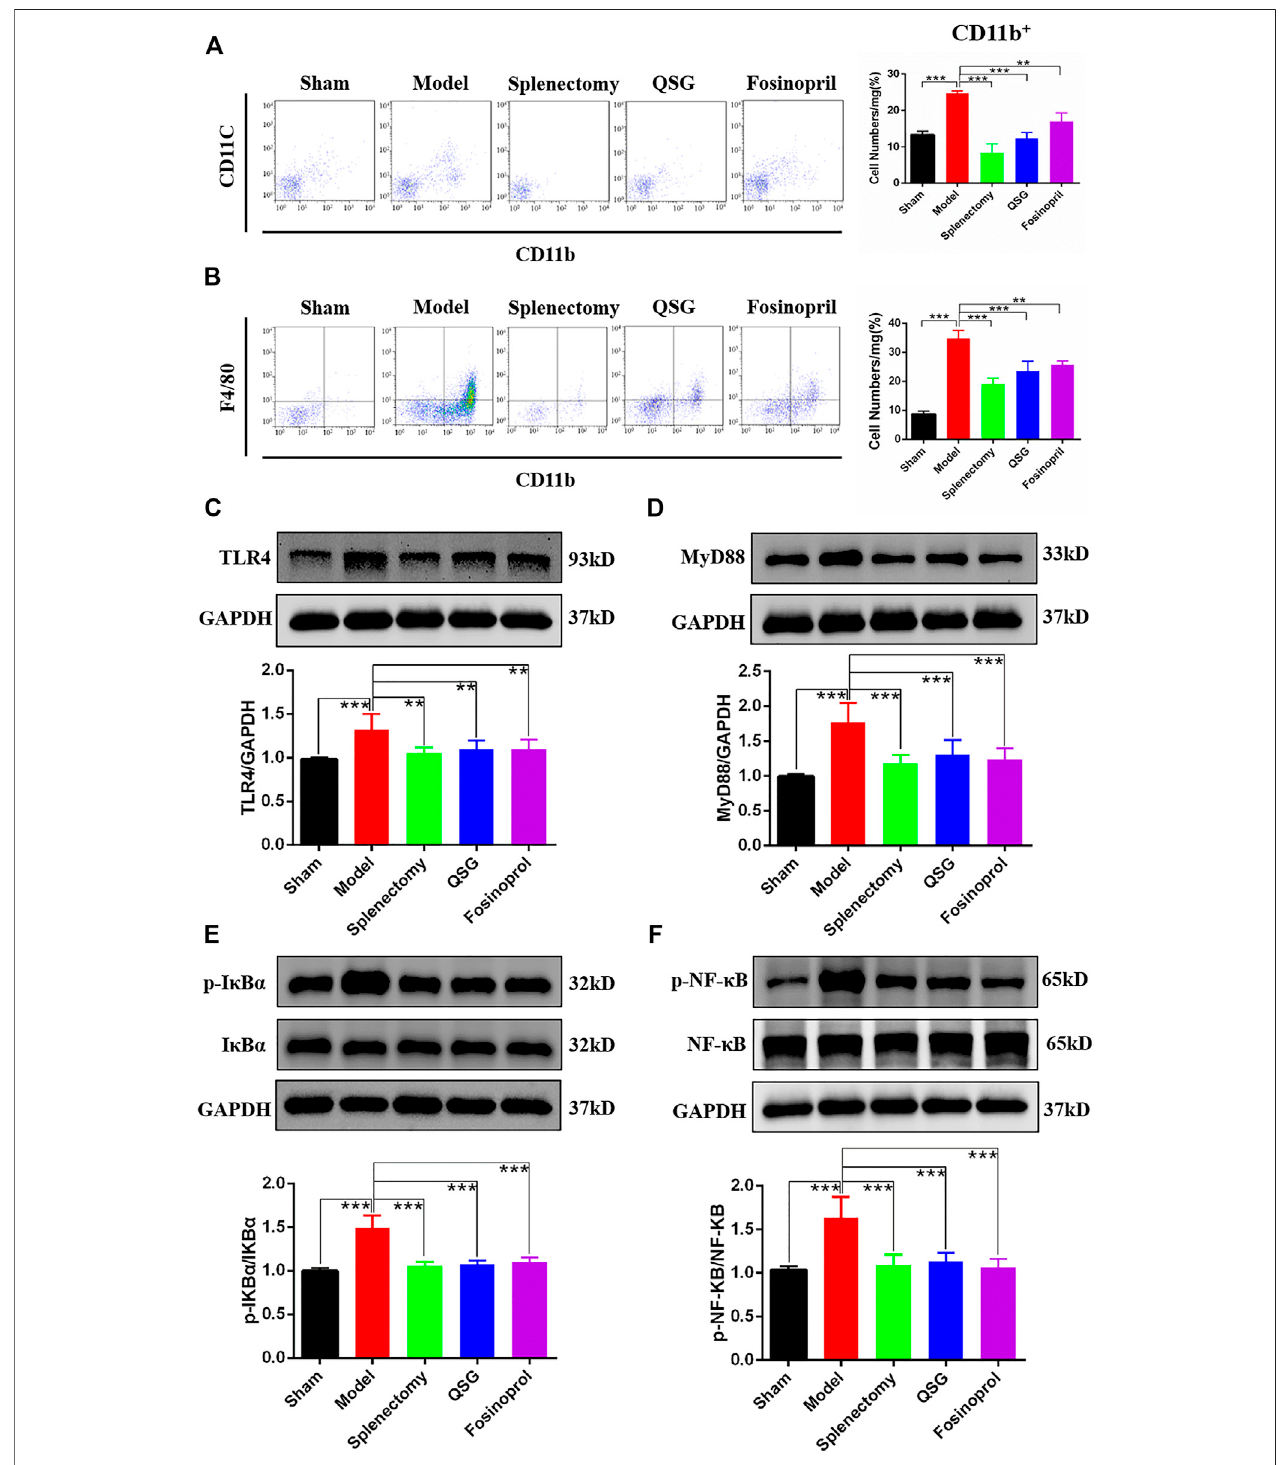
FIGURE3| QSGexertedananti-myocardialin fl ammationeffectthroughtheTLR4-MyD88-NF- κ Bp65pathwayinHFmice. (A) FlowcytometrydetectionofCD11b monocytes inblood and statistical analysis.N =3 per group. (B) Flow cytometry detection ofmonocytes/macrophages inheart and statistical analysis. N= 3per group. Representativewesternblotimagesand quanti fi cationofthreeexperimentsofTLR4 (C) ,MyD88 (D) ,p-I κ B α (E) ,andp-NF- κ Bp65 (F) inmyocardialtissue.GAPDHwas used as a loading control. N = 6 per group. ** p < 0.01, *** p < 0.001 vs. model group.